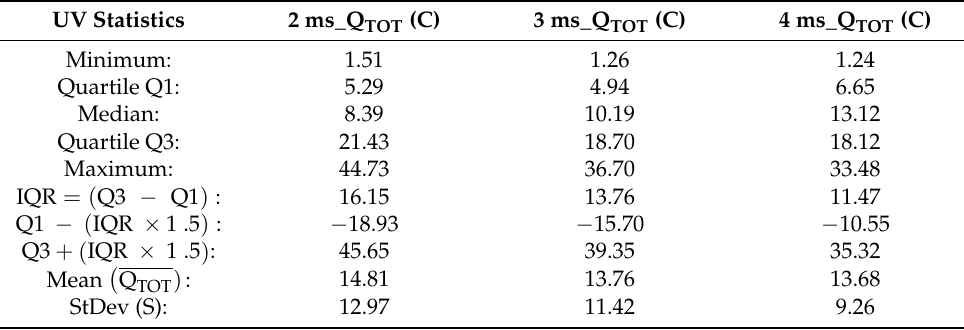
Table 2. UV five-number summary and outlier